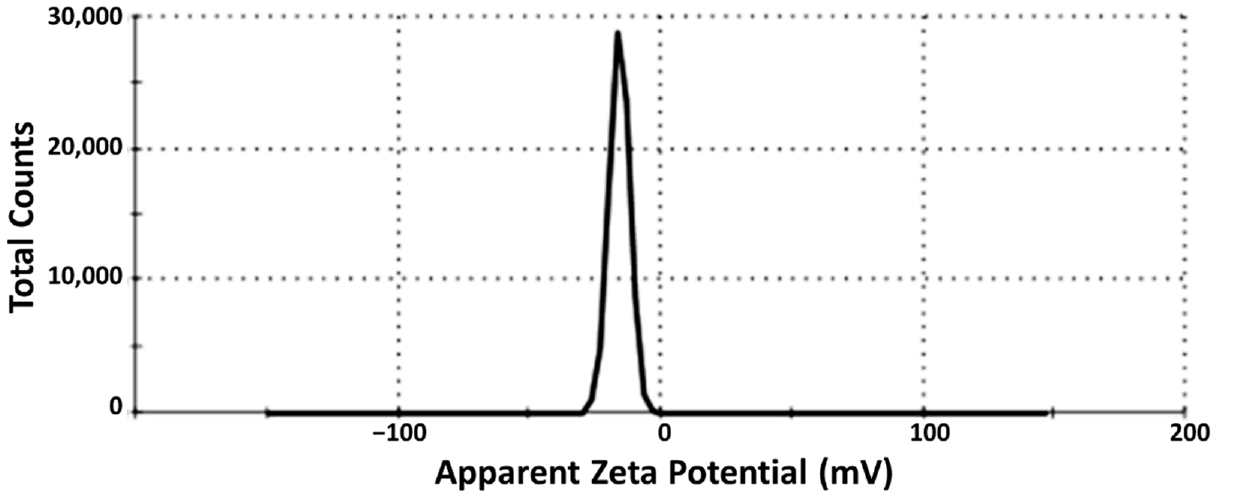
Figure 2. Zeta potential value of the selected drug-loaded SEDDS.